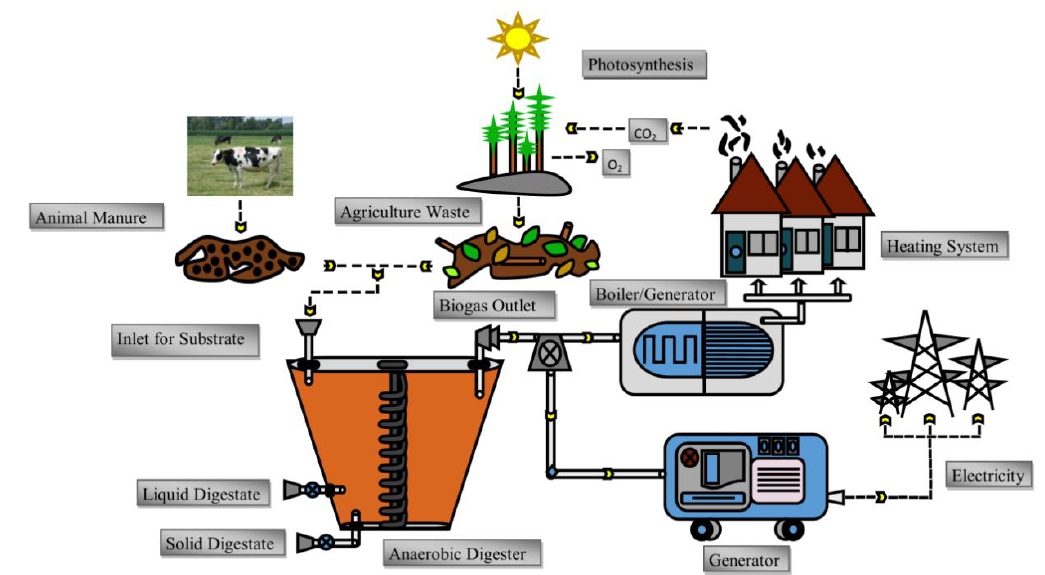
Figure 1. Waste utilization to produce renewable energy.